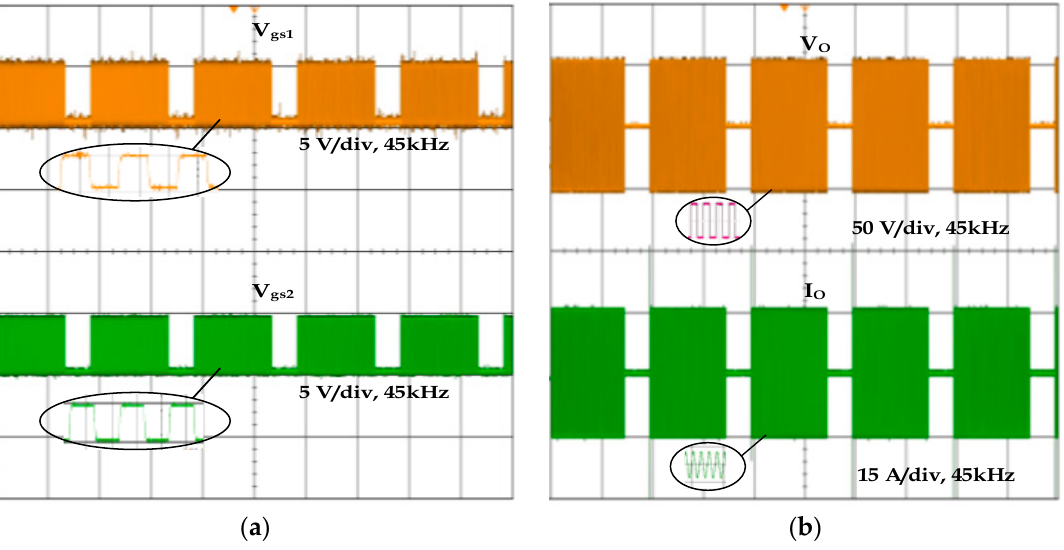
Figure 13. Experimental waveforms of Mode 2 with 75% PDM: ( a ) switching pulses and ( b ) output voltage and current.